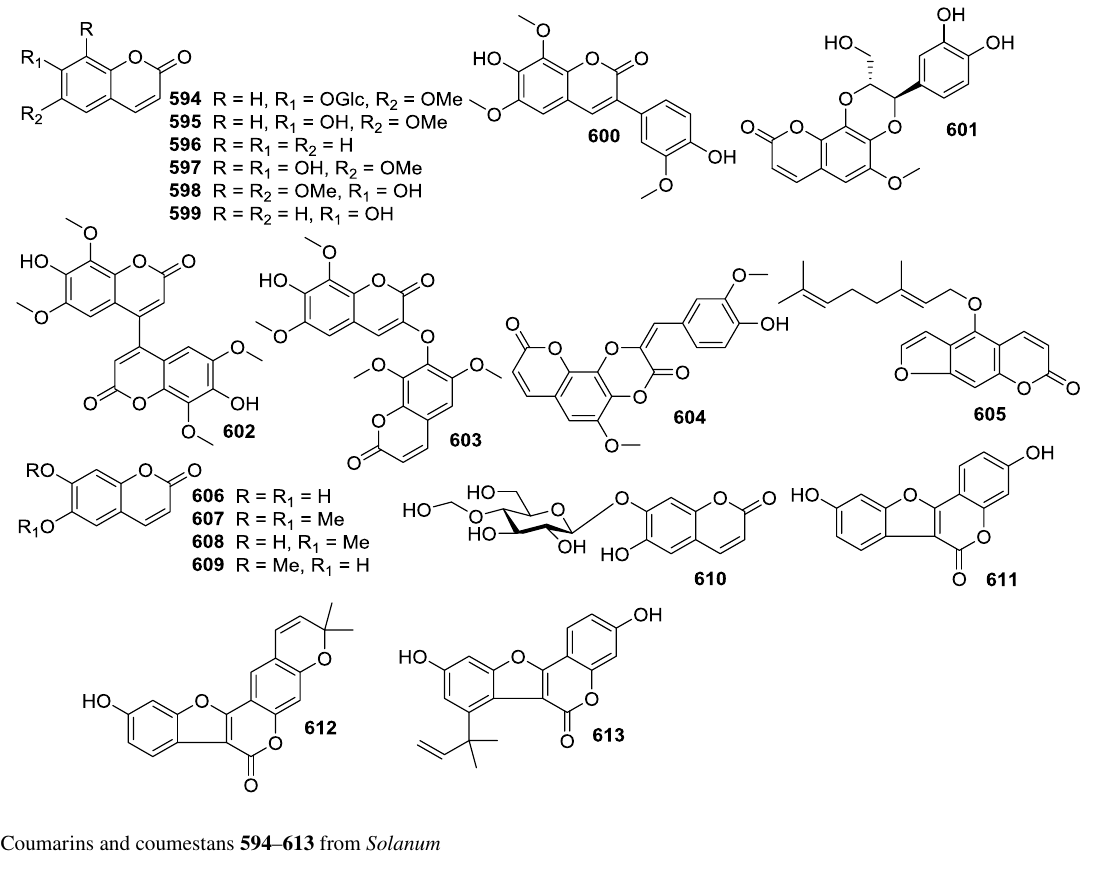
Fig. 13 Coumarins and coumestans 594 – 613 from Solanum